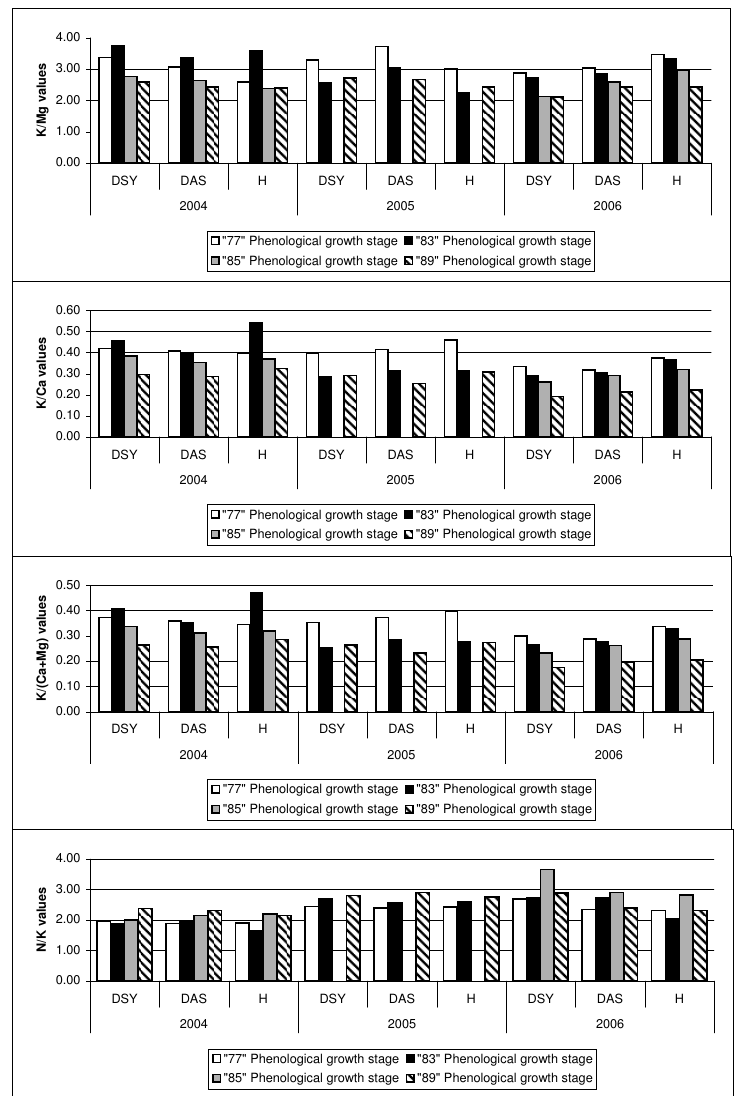
Fig.1. K/Mg, K/Ca, K/(Ca+Mg) and N/K ratios in leaves from sympto- matic (DSY), asymptomatic (DAS) and healthy vines (H). Data were collected at different phenological growth stages according to BBCH classi fi cation (Lorenz et al. , 1995): “77”, “Berries beginning to touch”; “83”, “Berries developing colour”; “85”, “Softening of berries”; “89”, “Berries ripe for